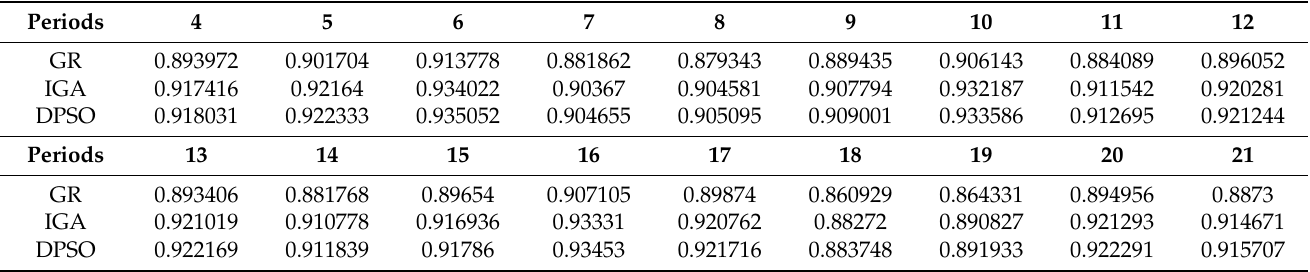
Table 11. Accuracy comparison data table of three algorithms simulation